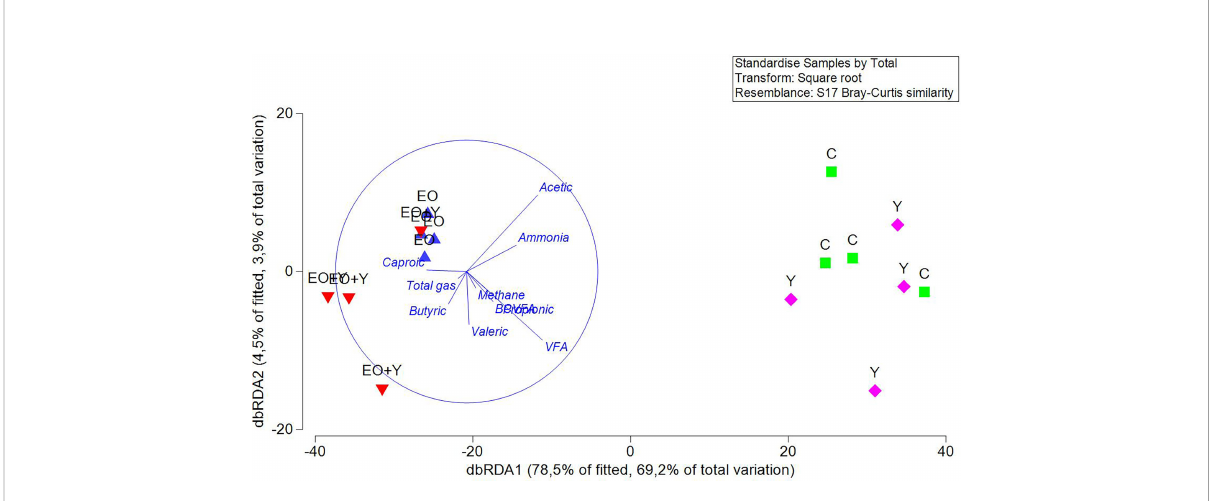
FIGURE 1 DbRDA illustrating the relationship between the structure of the bacterial community with the rumen fermentation pattern in the RUSITEC system. Arrows show the direction of the gradient. Samples belonging to each treatment are represented by blue and red triangles, essential oil alone or combined with yeast, respectively, green square for samples of the control treatment, and pink rhombus for those of the yeast treatment.